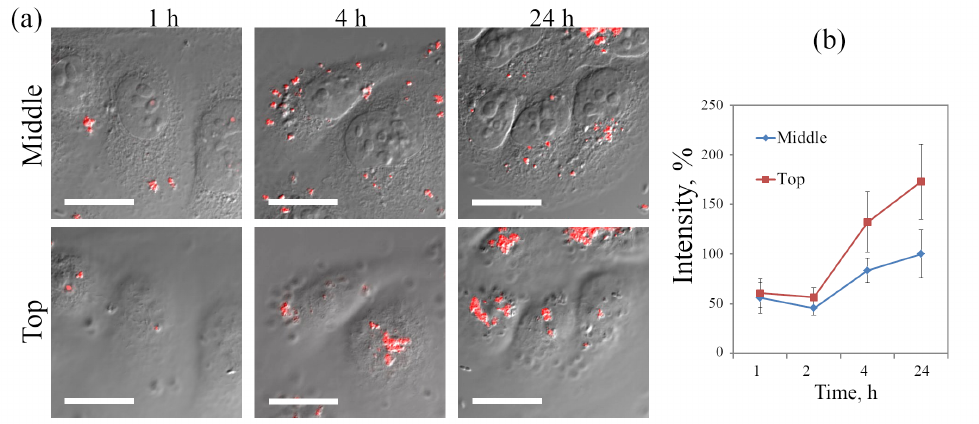
Figure 4. Dynamics of accumulation of QDs by HeLa and A549 cells, obtained by analysis of confocal images. ( a ) Confocal image of HeLa cells after culturing for 1, 4, and 24 h with QDs (50 nM). Typical optical sections from the Z-series at the level of the nucleus ( middle ) and on the apical surface ( top ) of cells; overlay of differential contrast images of cells and the QD luminescence channel are shown. ( b ) QDs’ apparent accumulation by HeLa cells during incubation for 1, 2, 4, and 24 h, plotted from the integral intensity of QD luminescence at the level of the nucleus ( middle ) and on the apical surface ( top ) of cells. The integral luminescence intensity of QDs per cell in the middle focal plane after 24 h of incubation is taken at 100%. Photoluminescence of QDs excited at 405 nm and recorded in the range of 520–620 nm. Scale bars 15 µ